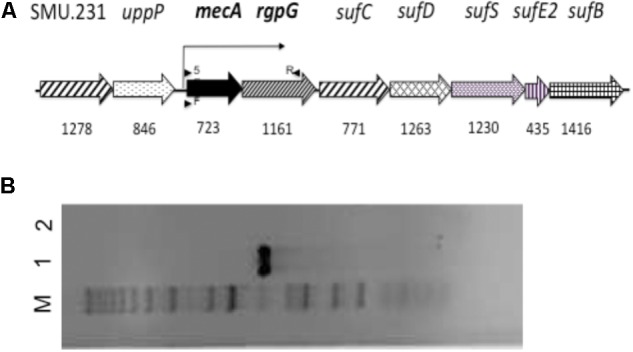
The schematic diagram of the mecA flanking region (A) and RT-PCR analysis (B). (A) Schematic diagram of the flanking regions of mecA in the genome of S. mutans UA159. Numbers underneath represent the size of the respective genes. Arrows above and underneath indicate the location and orientation of the primers used for reverse transcription (5) and cDNA amplification (F and R). (B) RT-PCR analysis of the mecA/rgpG cluster. cDNA generated from reverse transcription using total RNA extract of S. mutans was PCR amplified using primer set PmecARgpG (lane 1), which shows a single amplicon indicative of co-transcription of mecA and rgpG. Negative control (lane 2) with no reverse transcriptase shows no DNA amplification. M, for molecular marker.